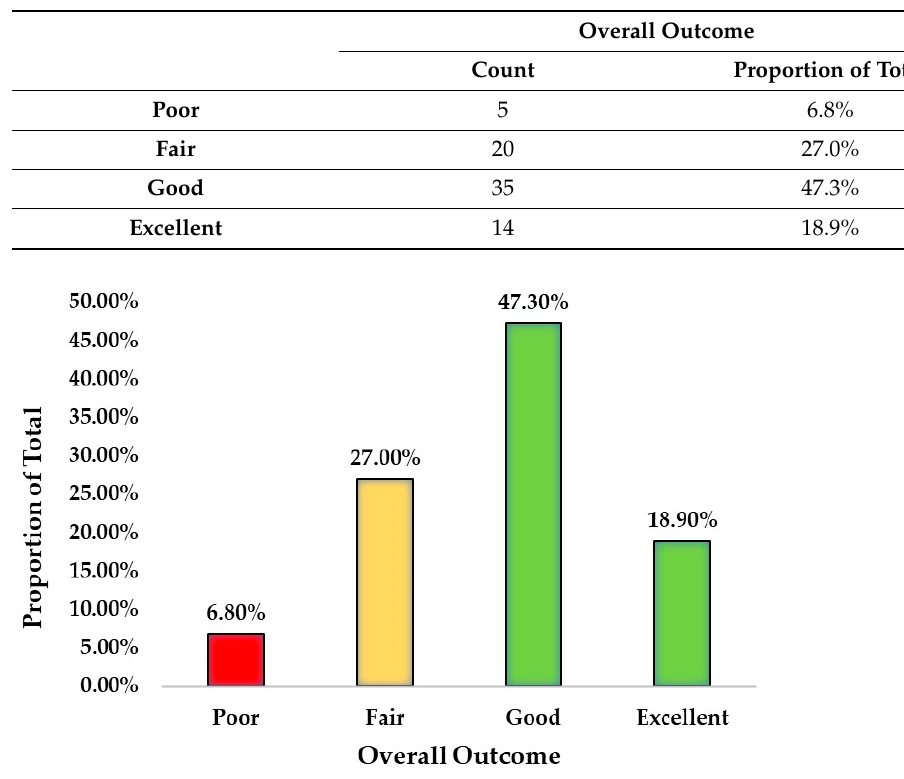
Figure 3. Overall outcome with H-Wave treatment.